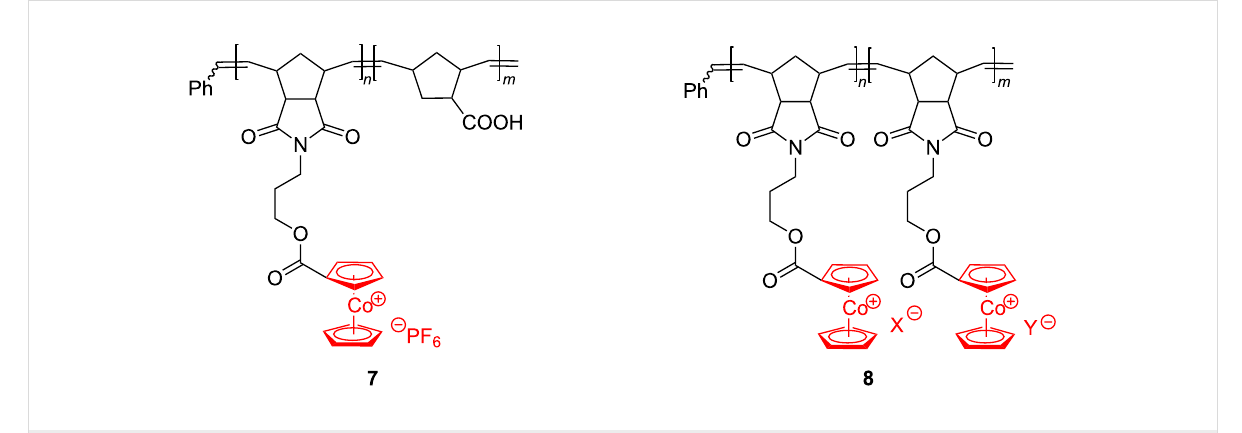
Scheme 4: Cobaltocenium-appending copolymers by the ROMP approach (X = PF 6 , Y = BPh 4 or